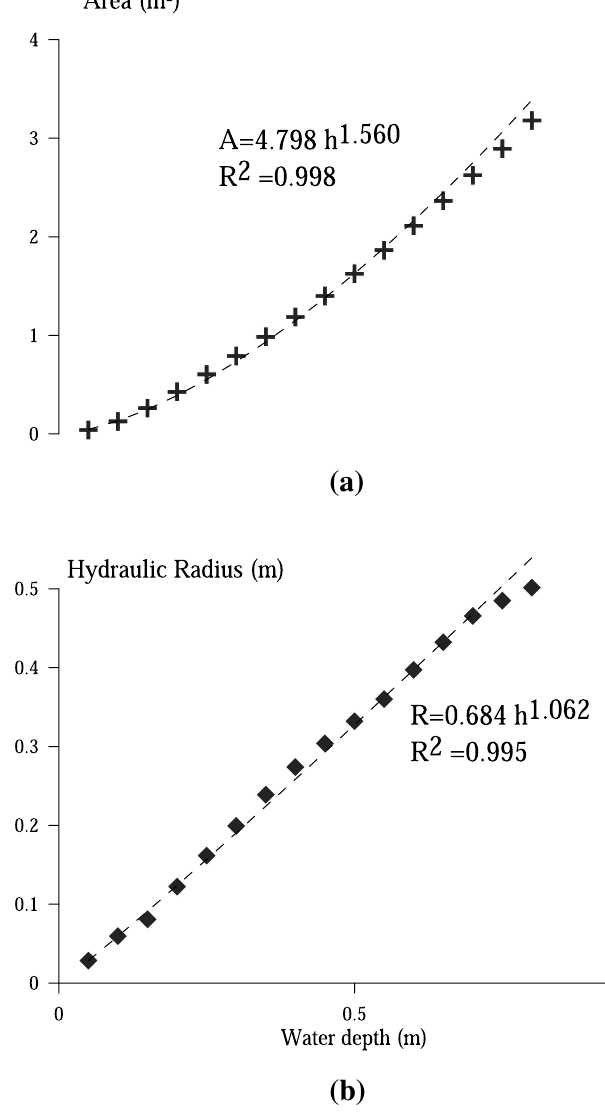
Fig. 5 Area and Hydraulic Radius data of the equivalent cross‑section. a Area, b Hydraulic